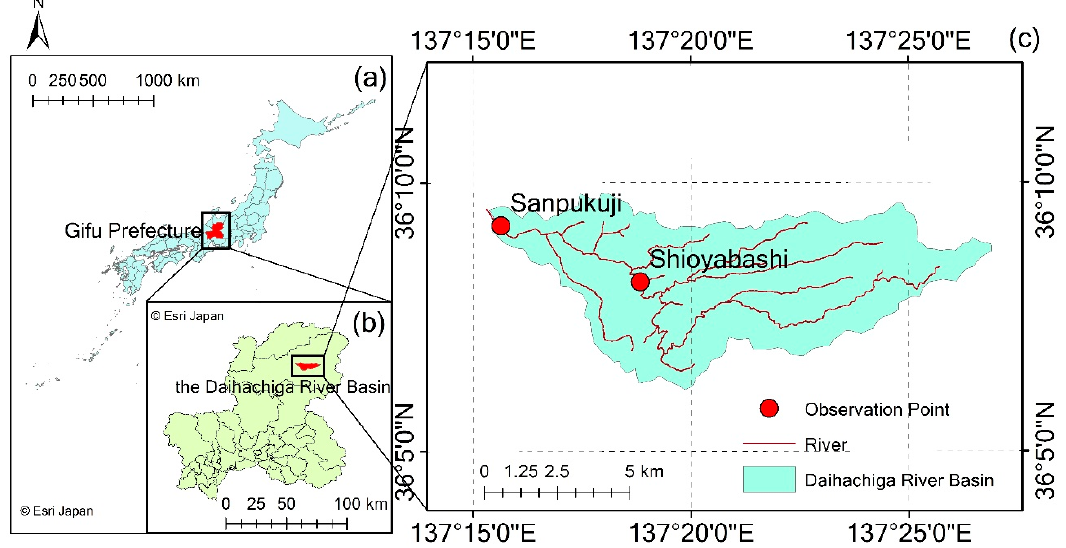
Figure 1. The Daihachiga River Basin and observation points. ( a ) Location of Gifu Prefecture; ( b ) location of the Daihachiga River Basin; ( c ) observation points of the Daihachiga River.